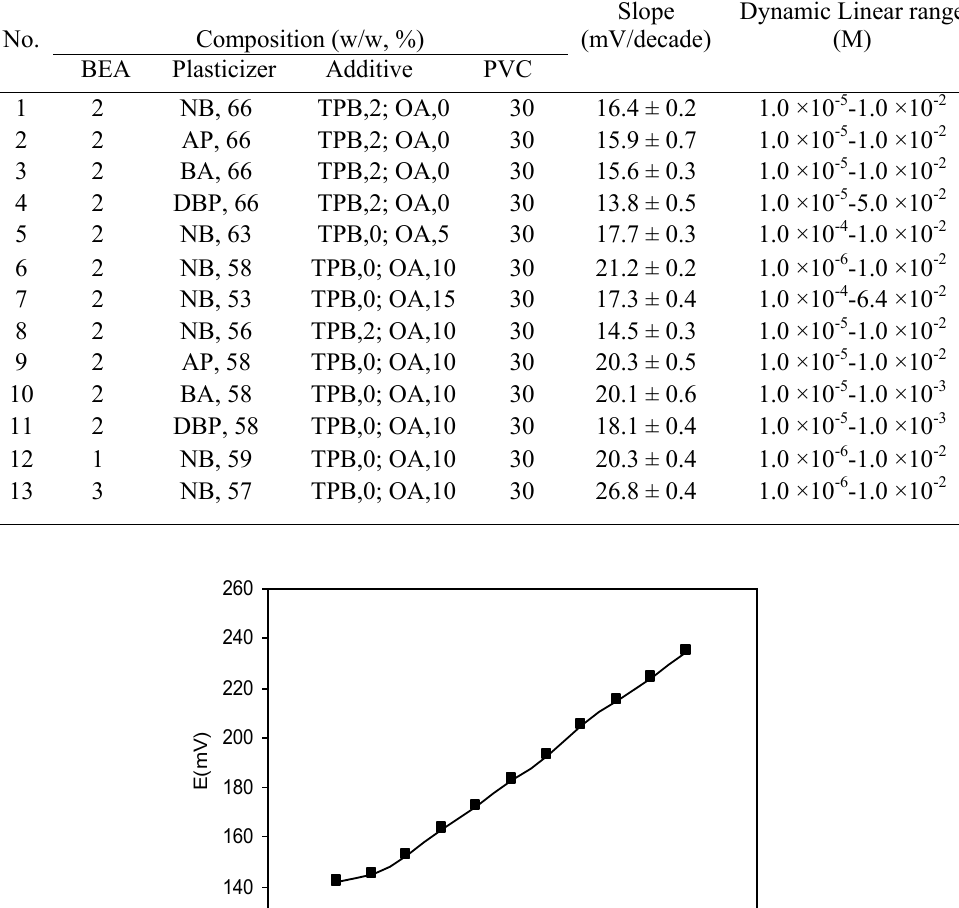
Table 1. Optimization of the membrane ingredients.